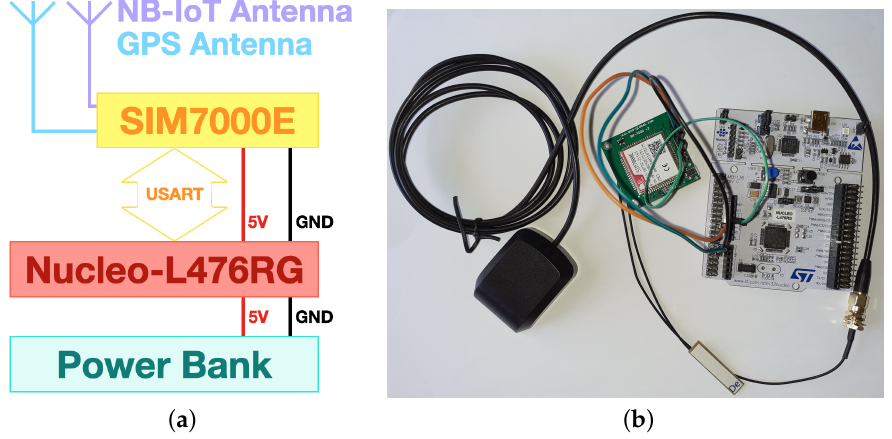
Figure 5. Tracker prototype: ( a ) block diagram; ( b ) hardware implementation without the power